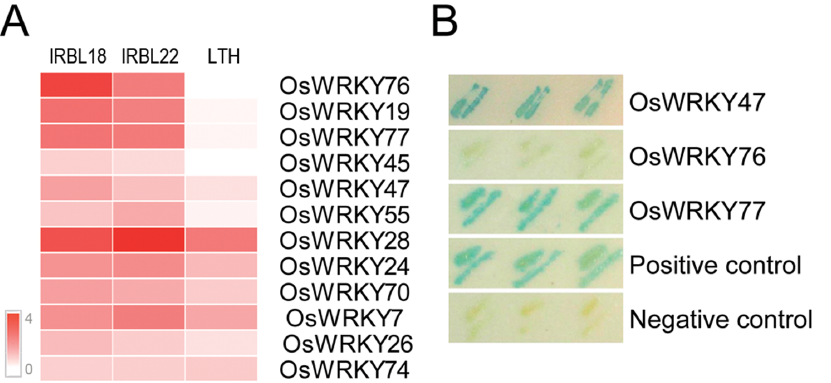
Figure 7. The expression patterns of OsWRKYs (A) and the trans-activation activities of selected OsWRKYs (B). The scale bar in (A) displays log2-transformed fold changes.